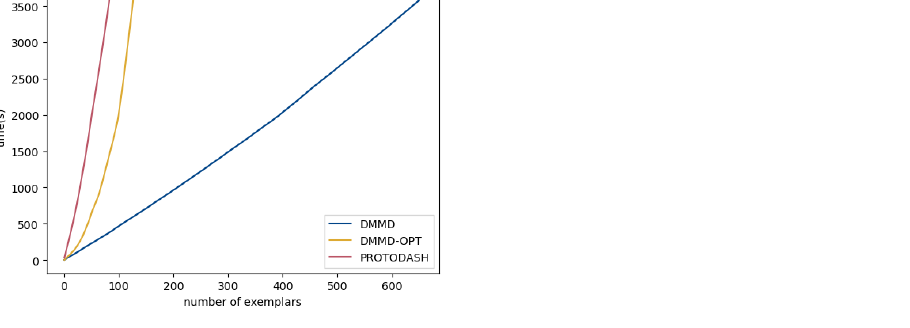
Figure 5. Time (in seconds) taken to construct MMD dependent coresets of a given size, for three algorithms, on the 12 yearbook datasets. Algorithms ran for a maximum of one hour.